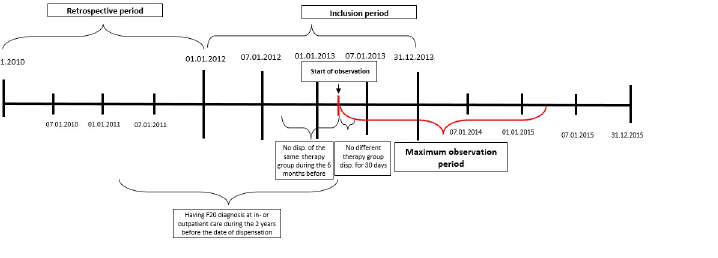
Fig 1. Patient inclusion and study